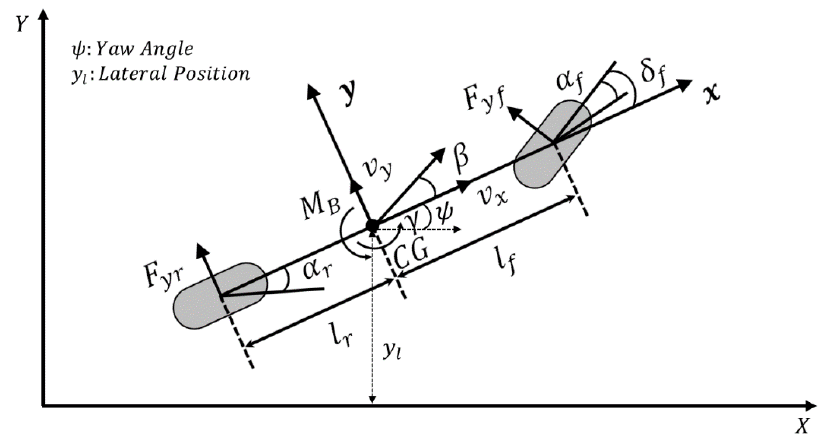
Figure 1. 2 degree of freedom (DOF) vehicle model.